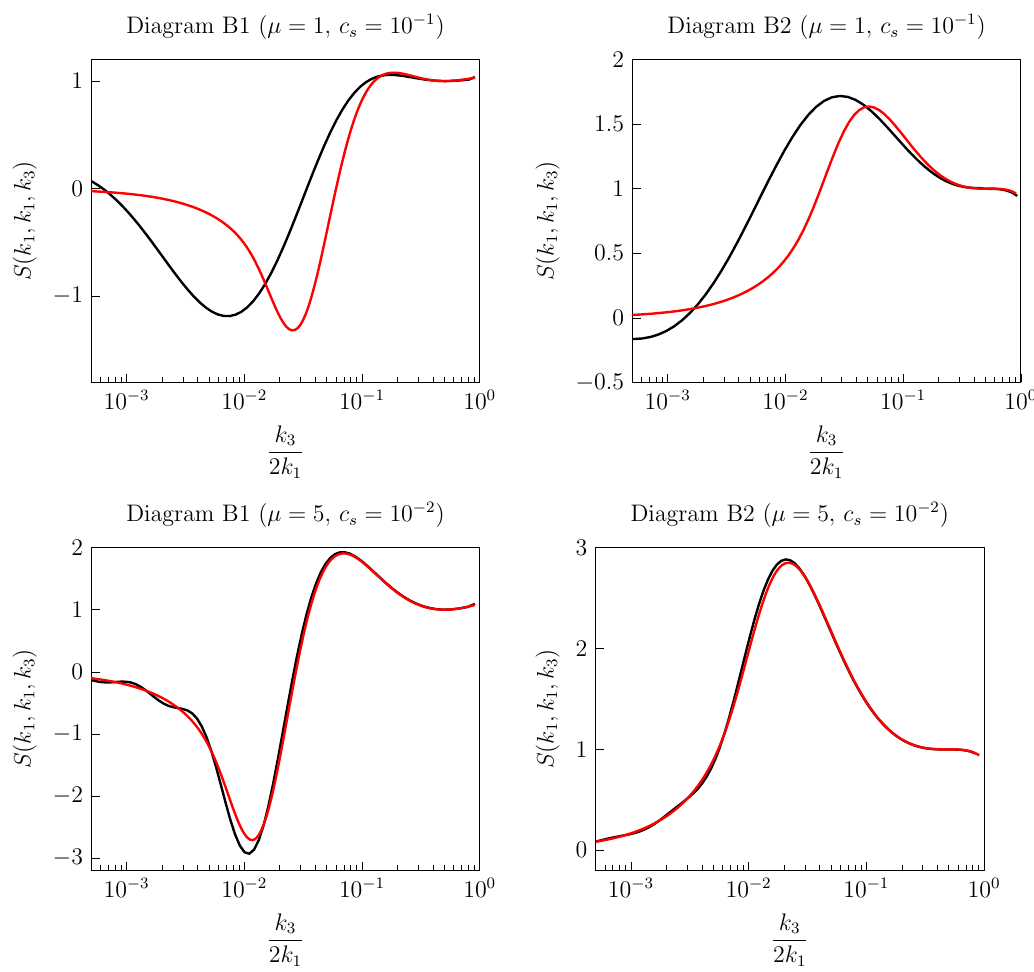
Figure 18 . Shapes S ( k 1 , k 1 , k 3 ) of the bispectra for isosceles triangles, normalized to unity in equilateral configurations, for diagrams B1 (left) and B2 (right), and for ( µ = 1 , c and ( µ = 5 , c = 0 . 01) (bottom). The black curve is the exact bootstrap result and the red curve s corresponds to the leading-order non-local EFT predictions